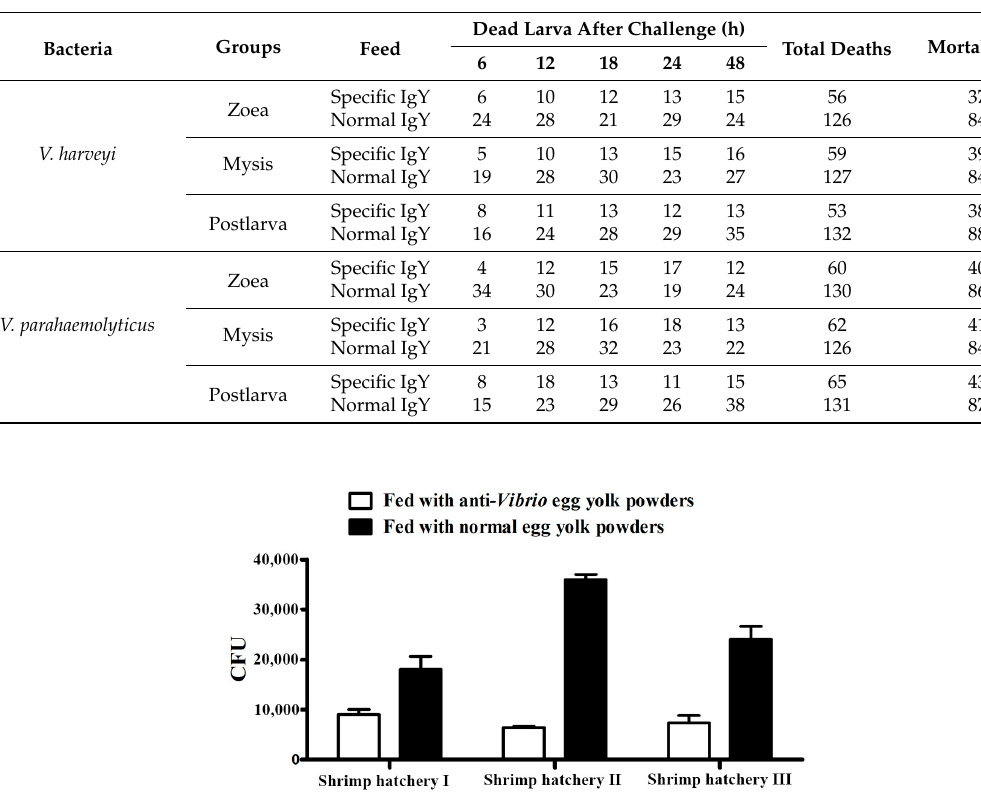
Table 2. Effects of dietary specific egg yolk powder on the survival rate of zoeae, mysis, and postlarva.